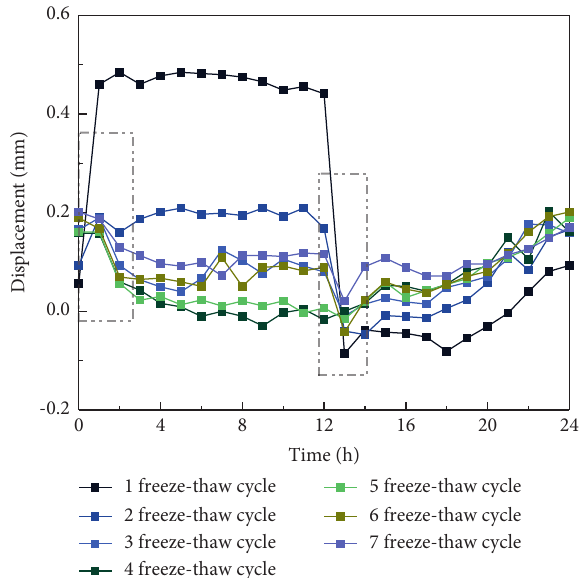
Figure 7: Curve of displacement and